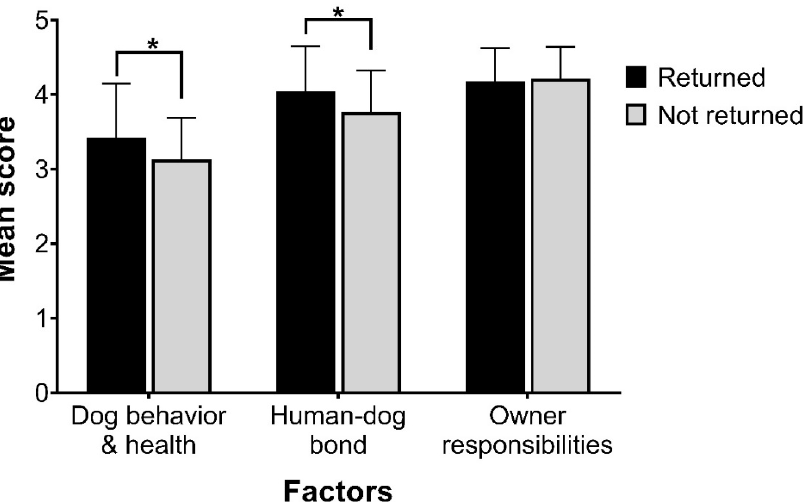
Figure 1. Mean factor scores ± standard deviation for owner expectations. * Indicates there was a statistically significant difference between return and non-return owners ( p < 0.05). Table 3. Expectations by return status.